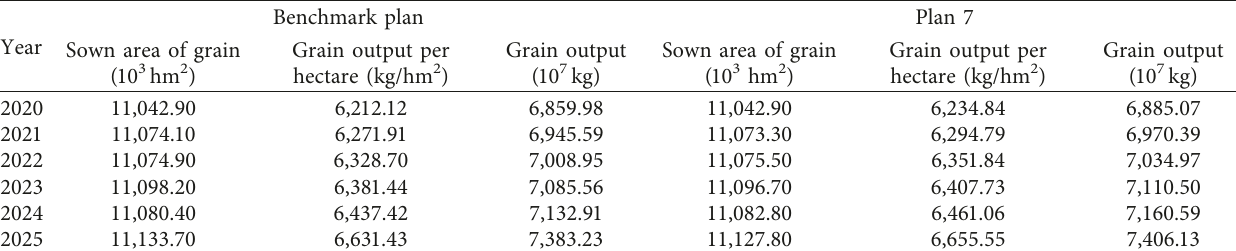
Figure 8: Comparison of simulation results between Benchmark plan and Plan 6. Table 9: Comparison of simulation results between Benchmark plan and Plan